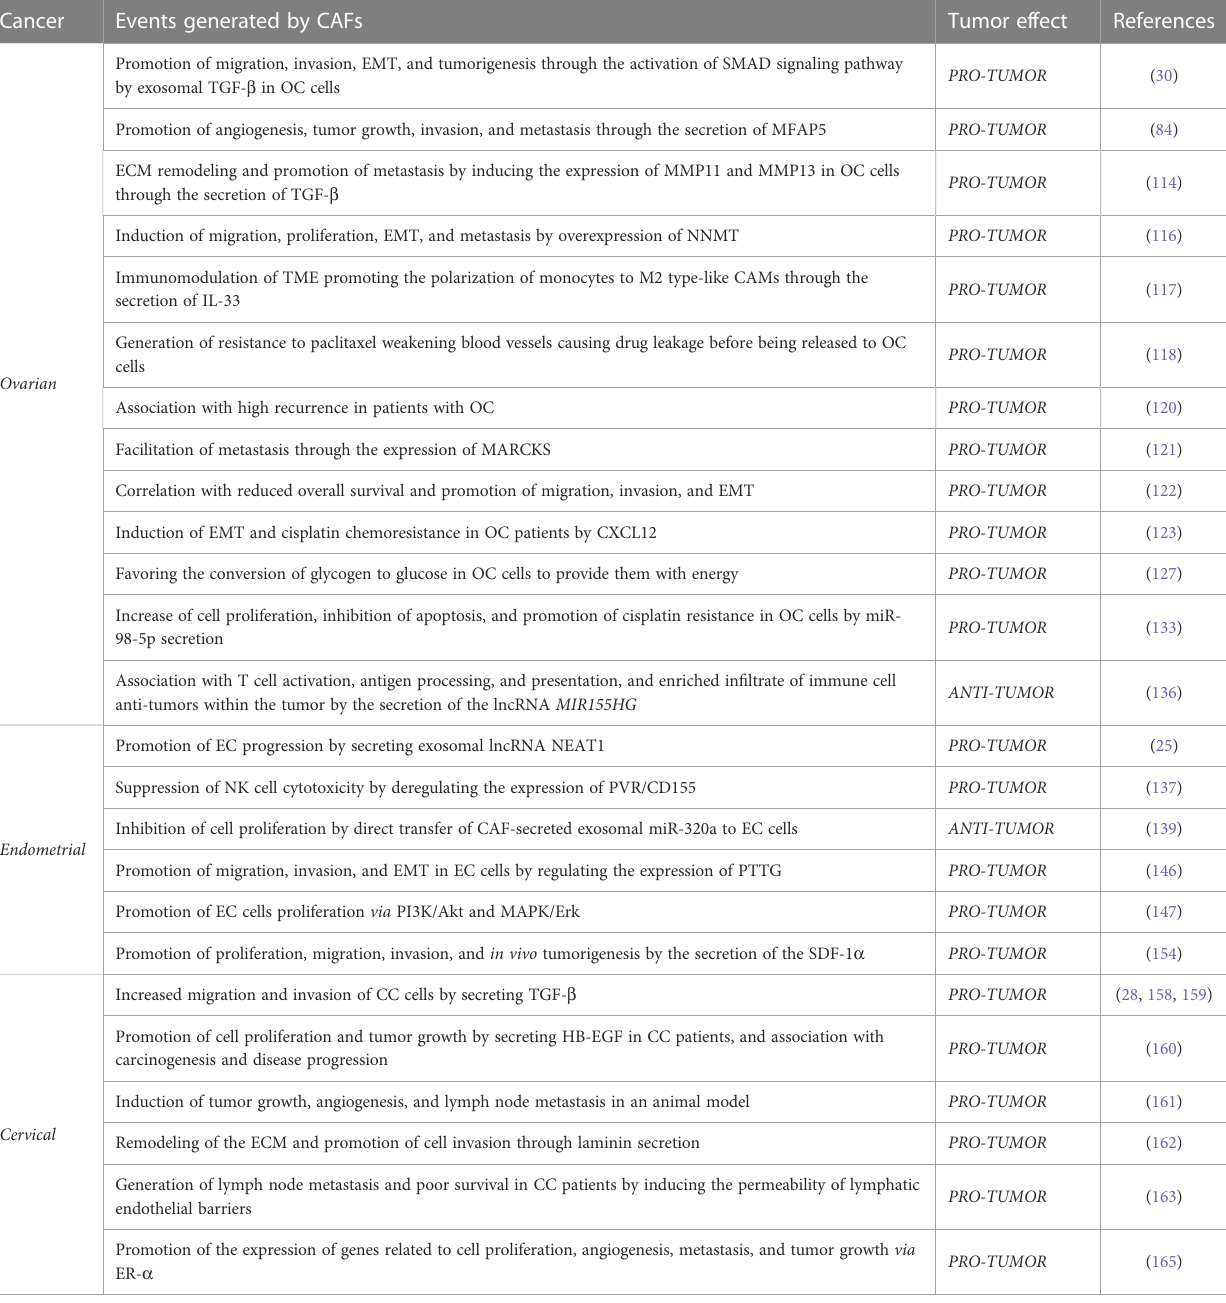
TABLE 1 Events generated by CAFs and tumor effect in gynecological cancers. Cancer Events generated by